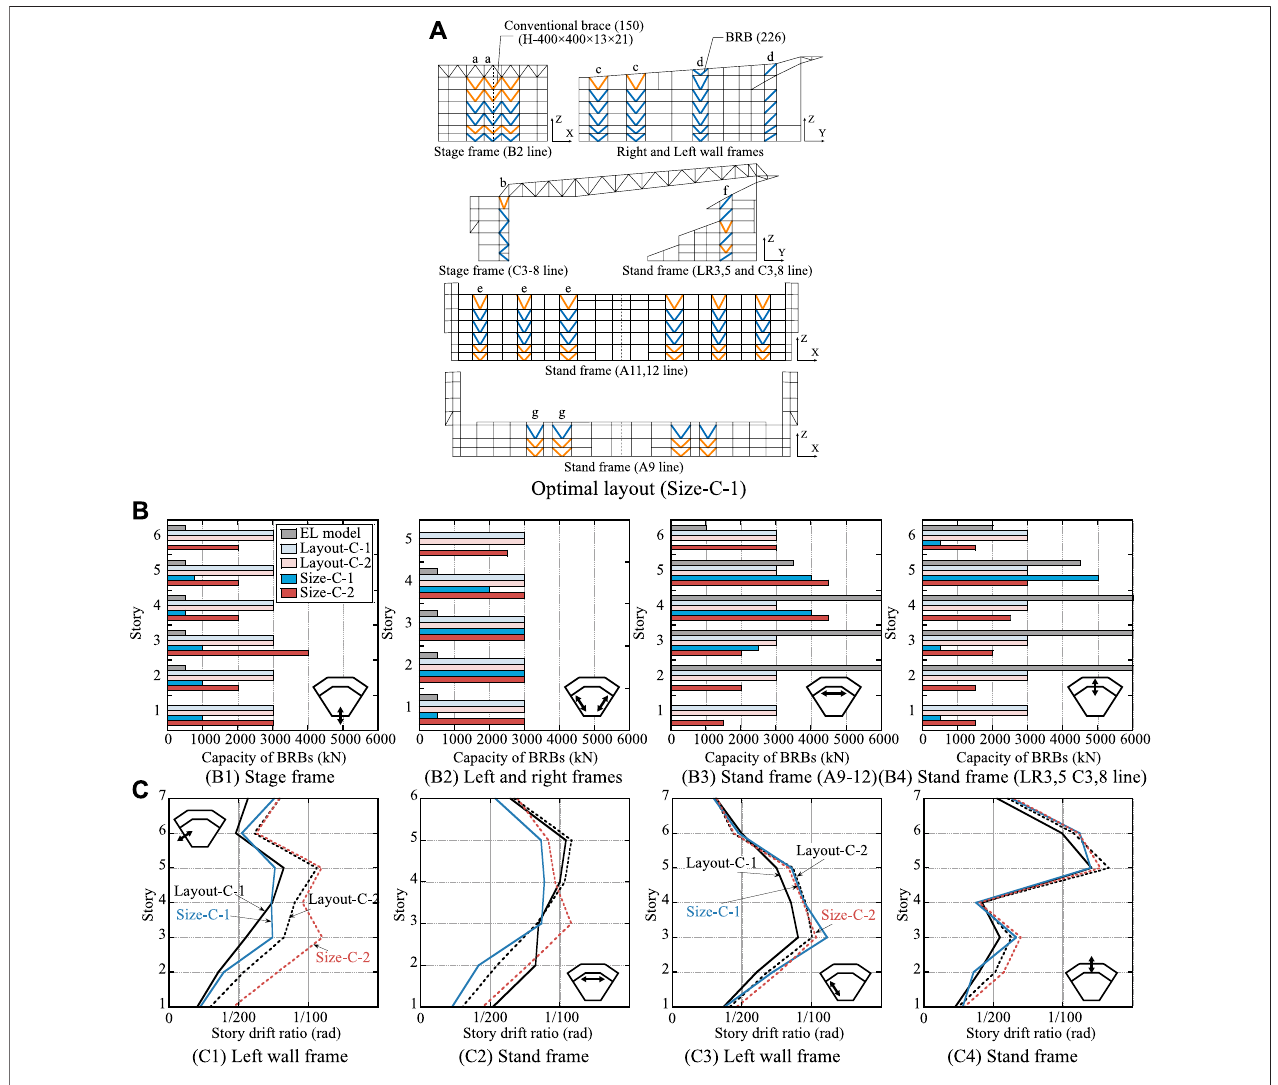
FIGURE 10 | Optimal solution (Size-C-1 and Size-C-2): (A) Optimal placement (Size-C-1), (B) Capacity distribution of BRBs, (C) Maximum story drift